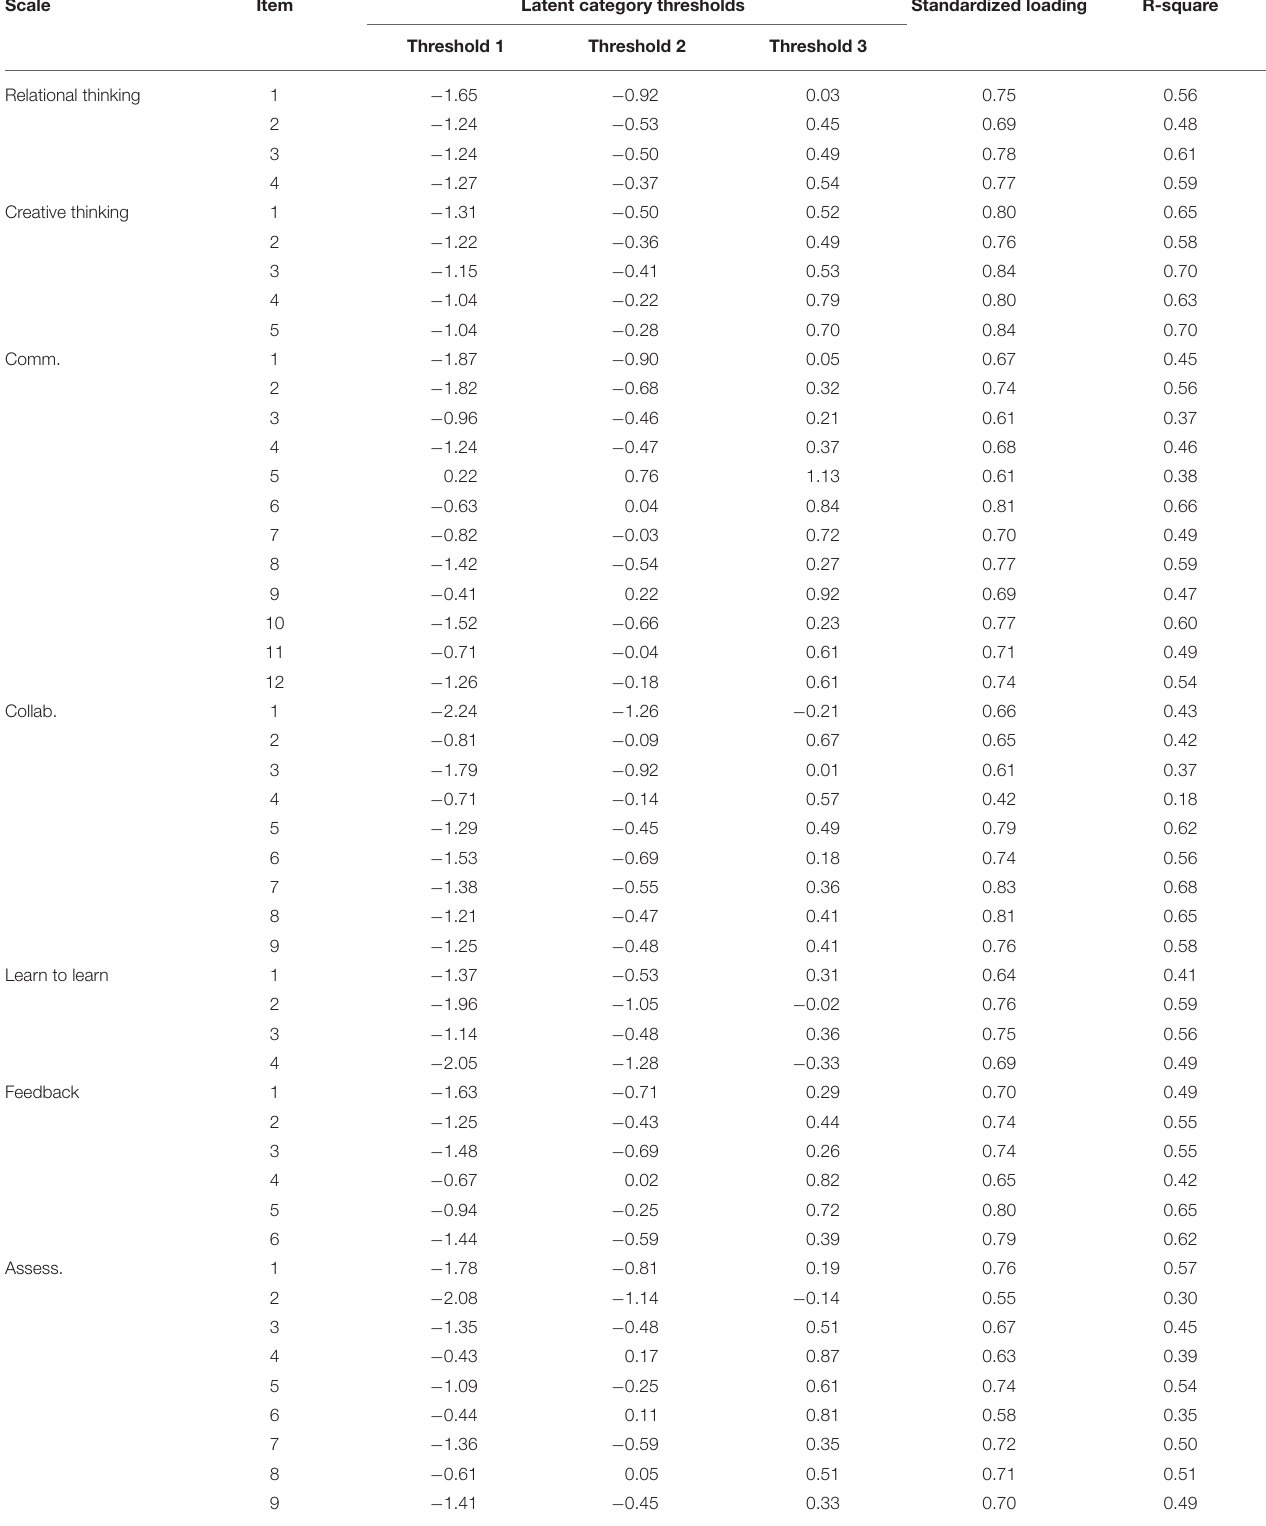
TABLE 6 | Model parameters for all administered